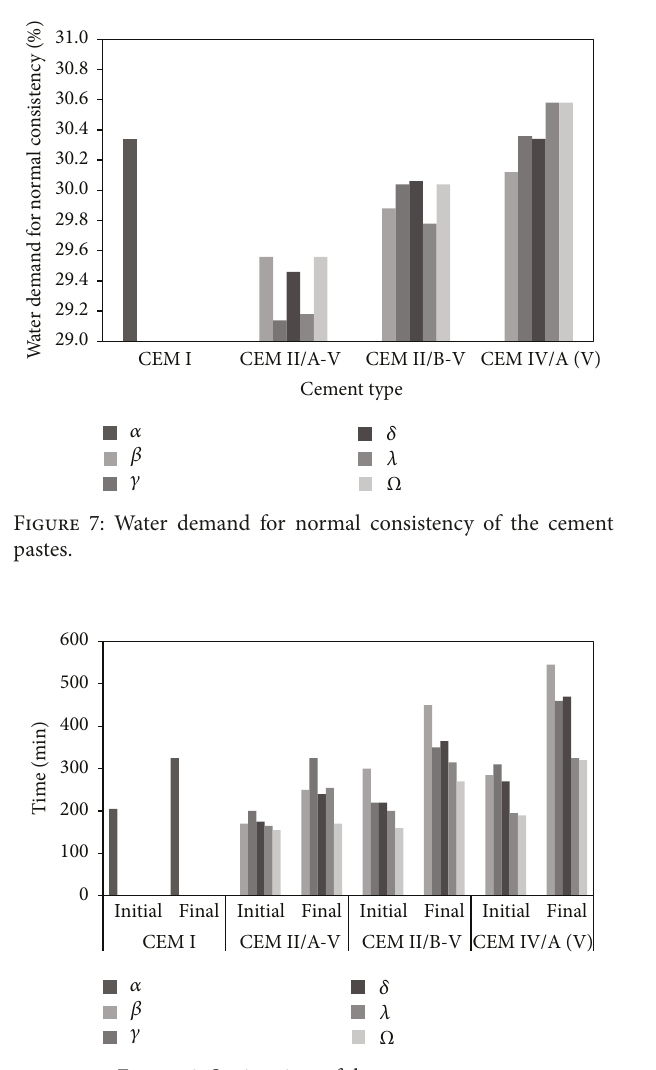
Figure 8: Setting time of the cement pastes.